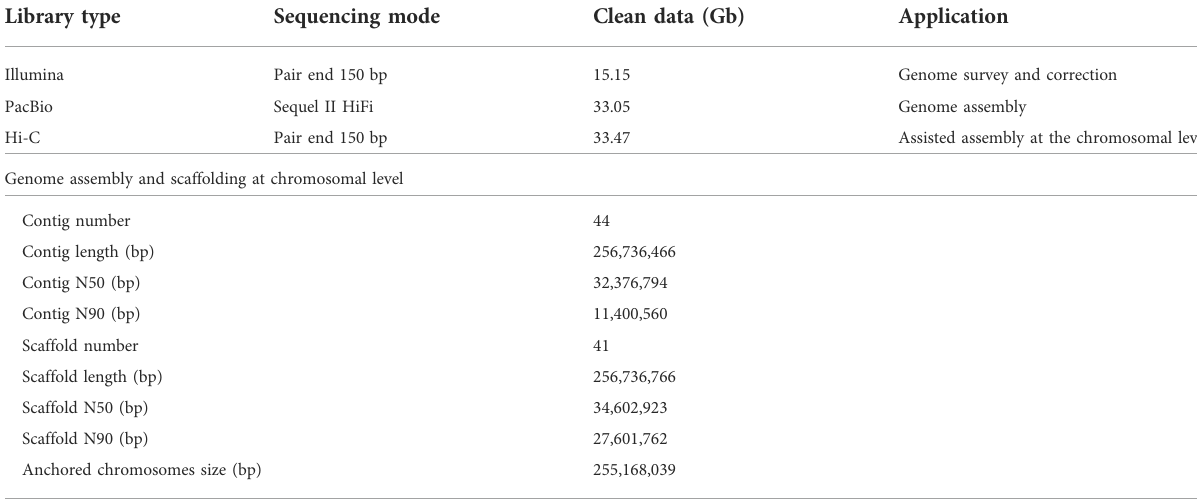
TABLE 1 Summary statistics of the sequencing and assembly of the Fragaria pentaphylla- FP039 genome. Library